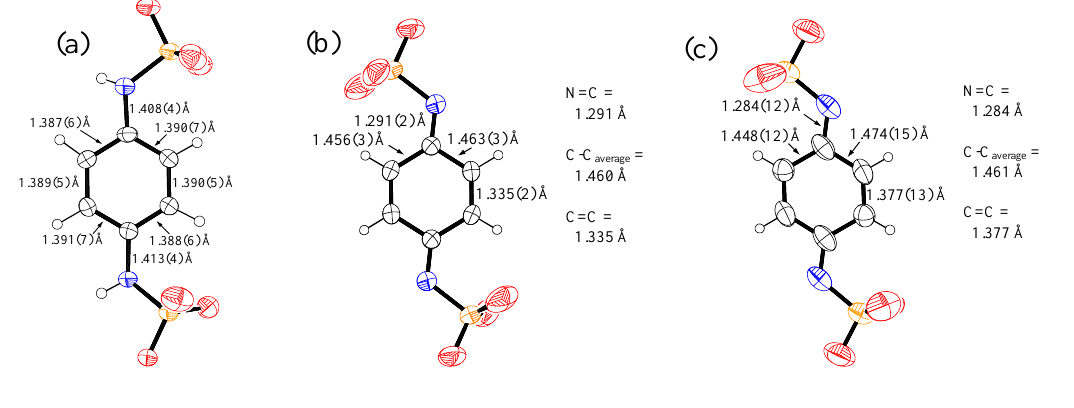
Figure 1. Molecular structures of (a) 2 in (PPh (ET) 1 ·3H O ( 3 4 2